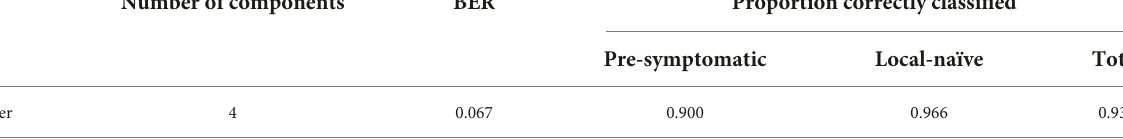
TABLE 7 Accuracy of the sparse partial least squares discriminant analysis (sPLS-DA) used to classify near-infrared (NIR) spectra based on tree symptom type for the September dataset. Time